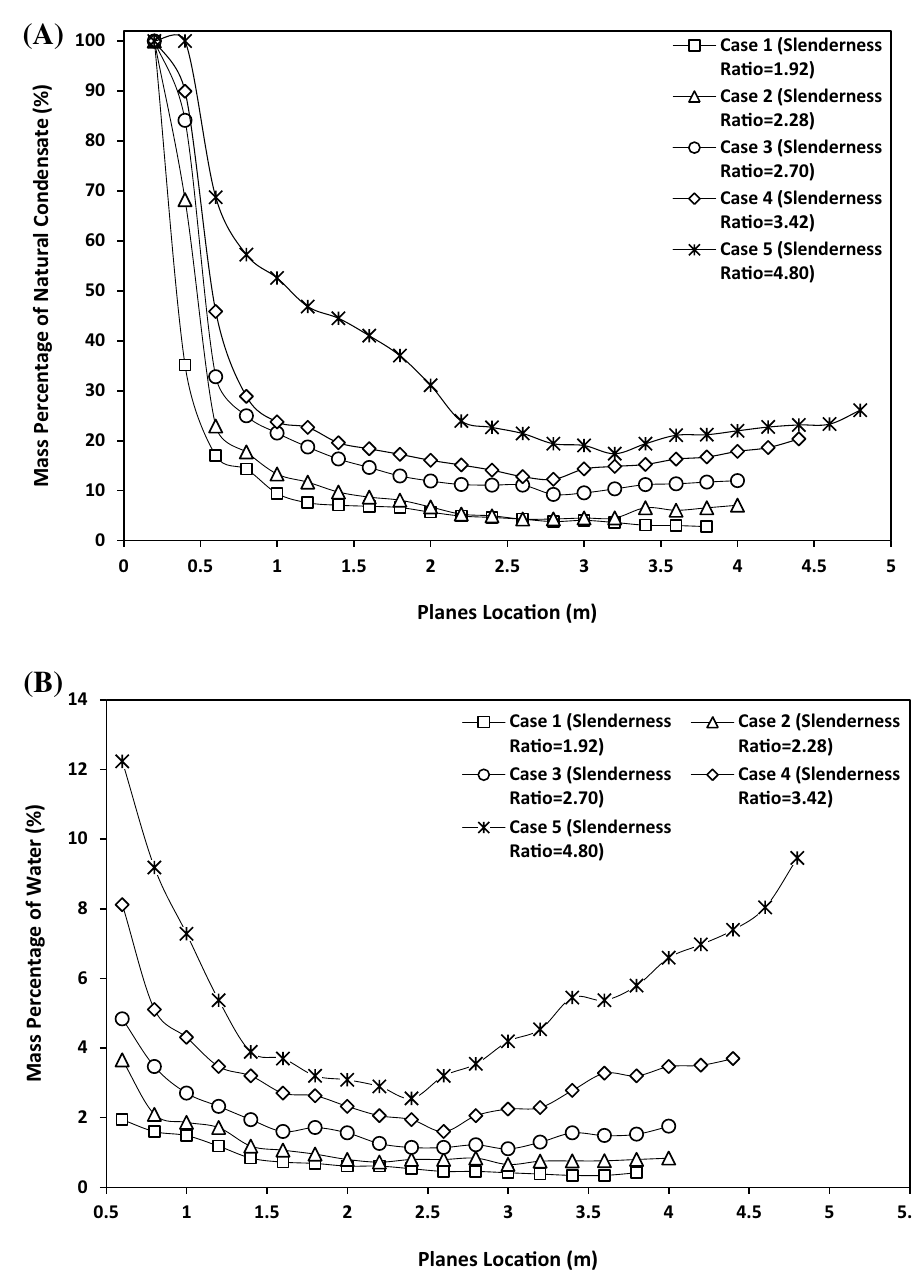
Fig. 14 Simulated mass distri- bution of condensate ( a ) and water ( b ) droplets in the gas zone of Cases